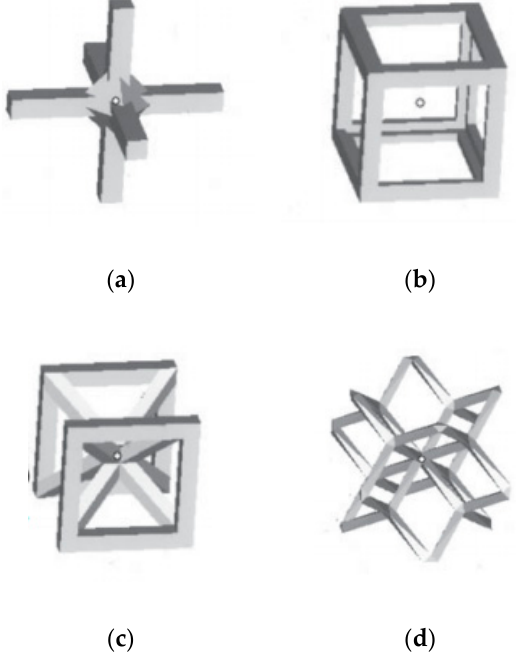
Figure A4. ( a ) Cross 1; ( b ) G6; ( c ) G7; ( d ) Dode Thin [146].